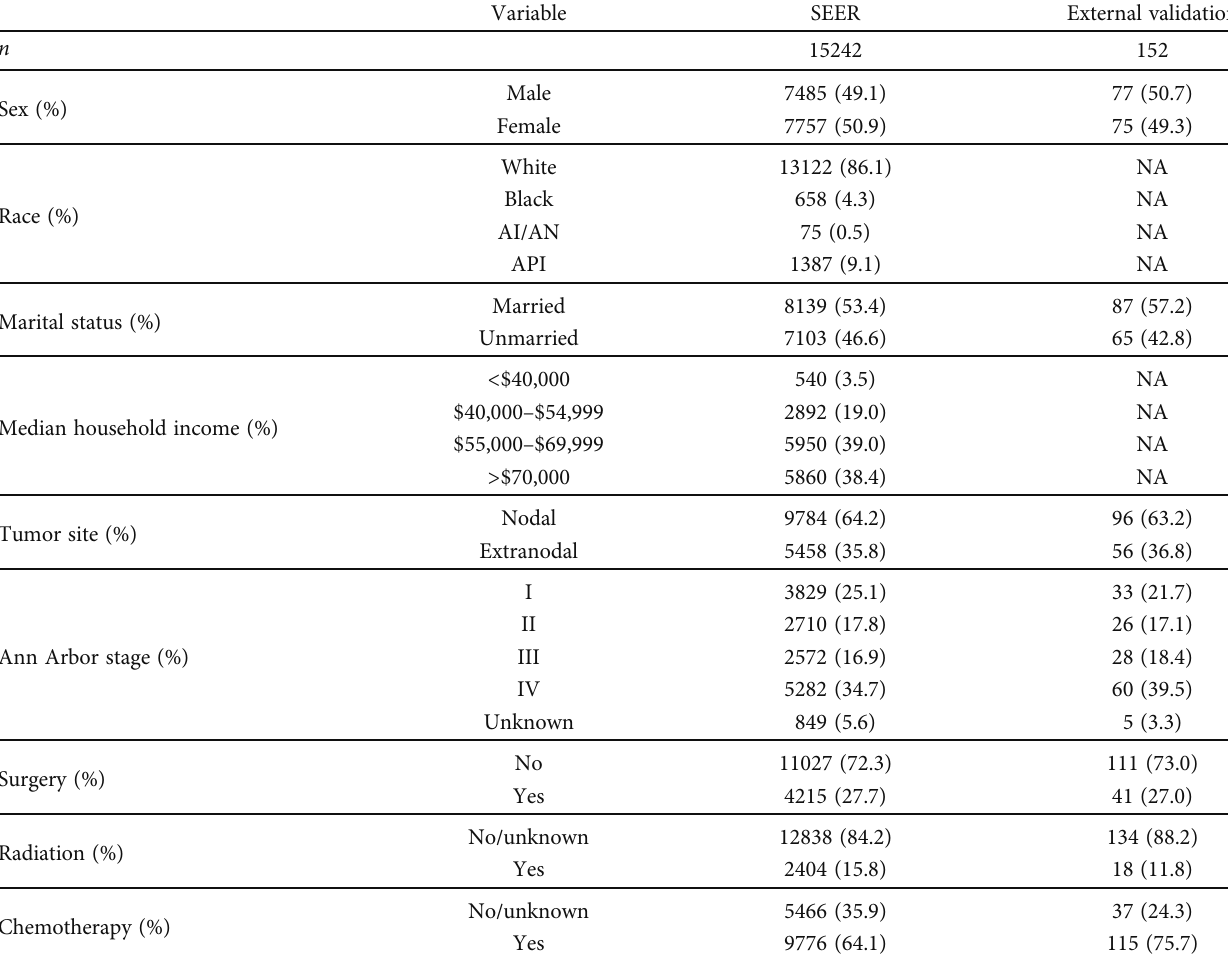
Table 1: Clinicopathological characteristics of patients in the SEER database and external